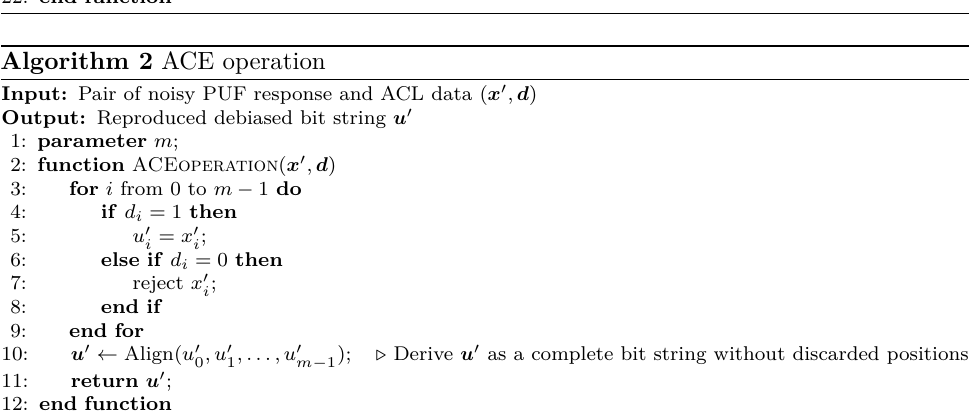
Algorithm 2 ACE